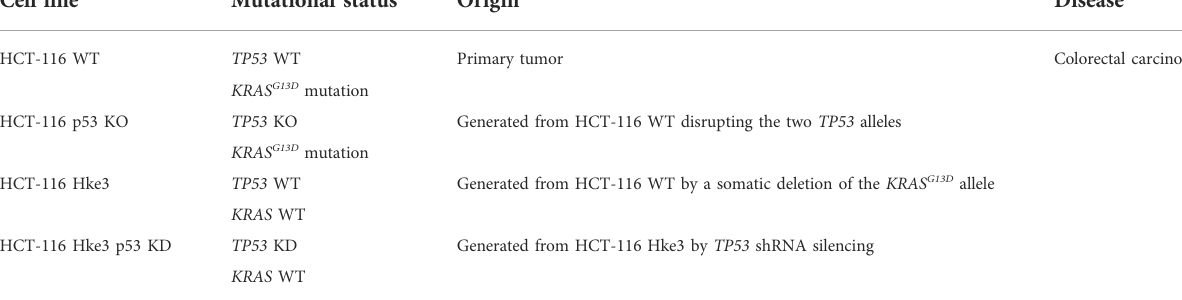
TABLE 1 Origin and mutations of human colorectal cancer HCT-116 cell